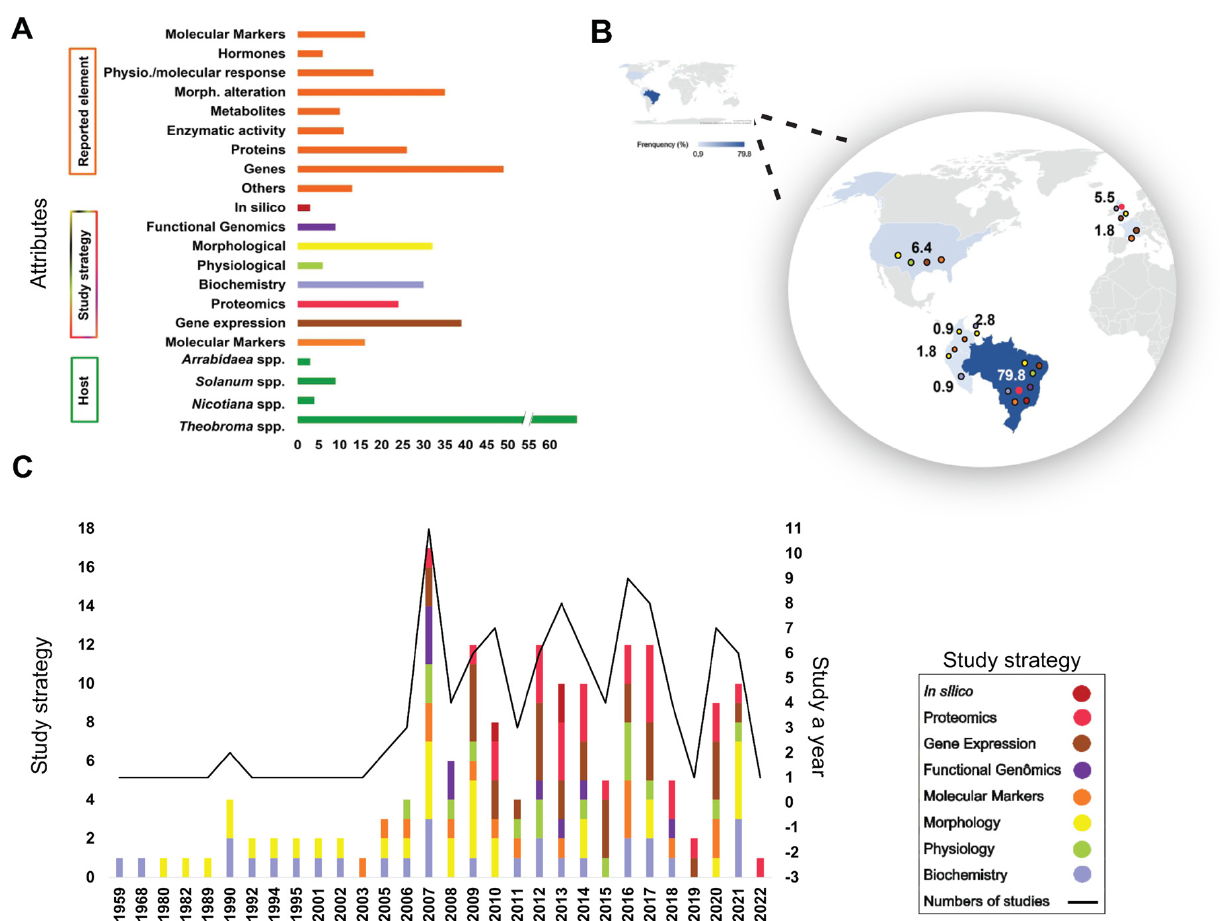
Figure 2. Bibliometric indicators of selected studies of the molecular biology of the interaction between M. Perniciosa and its hosts: ( A ) attributes identified in the papers; ( B ) frequency of coun- try studies with their respective study strategies; and ( C ) frequency of studies per year. Physio.: Physiological; Morph.: